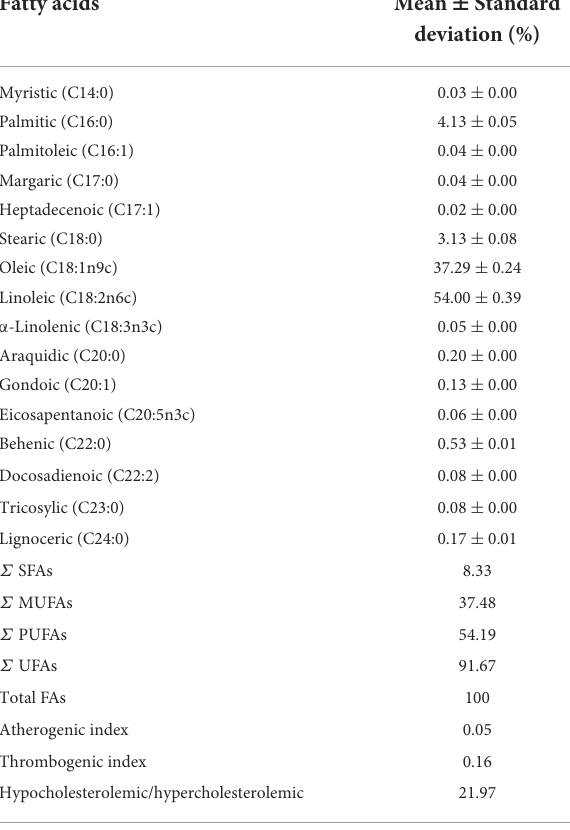
TABLE 2 Fatty acid composition of sunflower oil extracted by cold pressing.